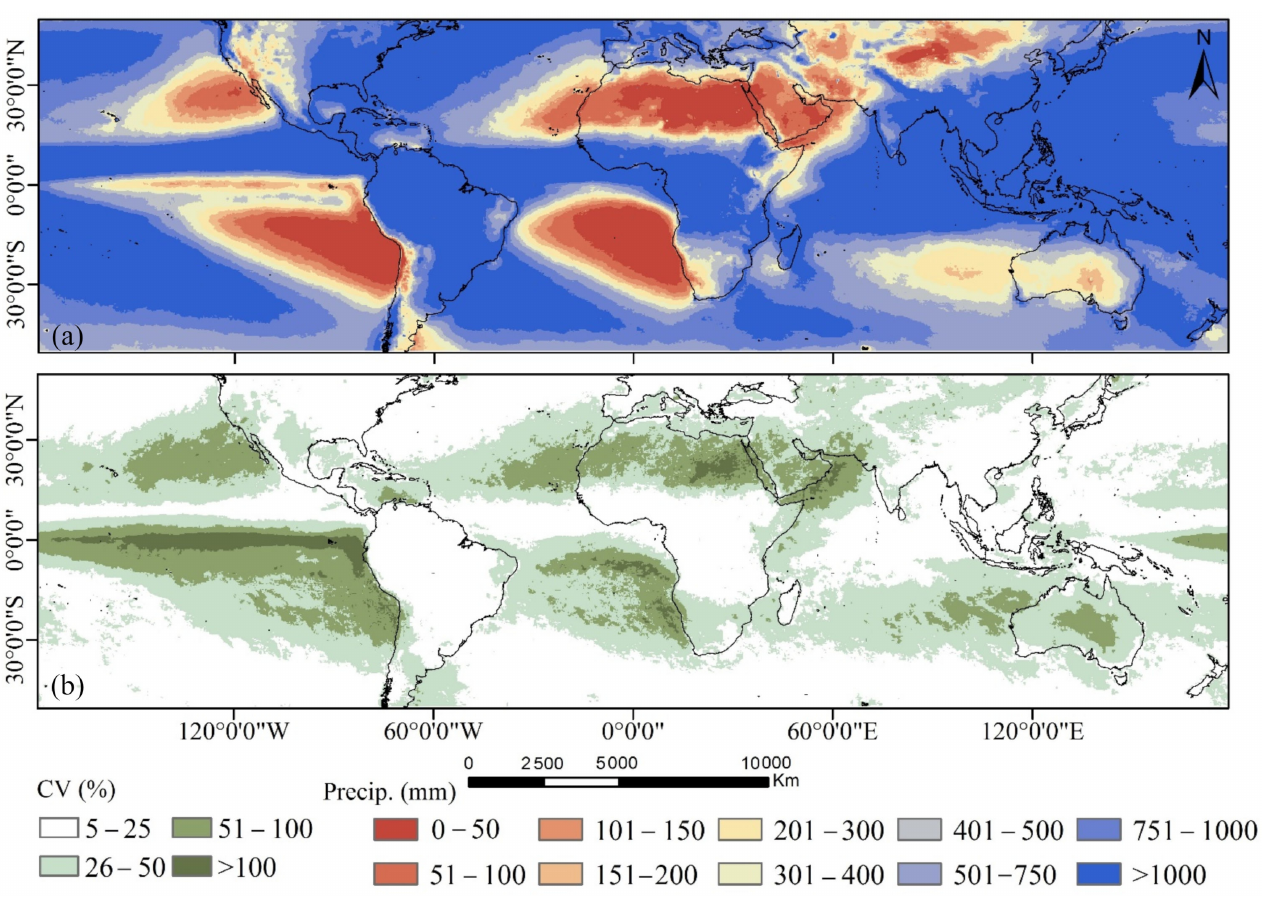
Figure 2. ( a ) Mean annual precipitation and ( b ) coefficient of variation (CV) between 1998 and 2019 in